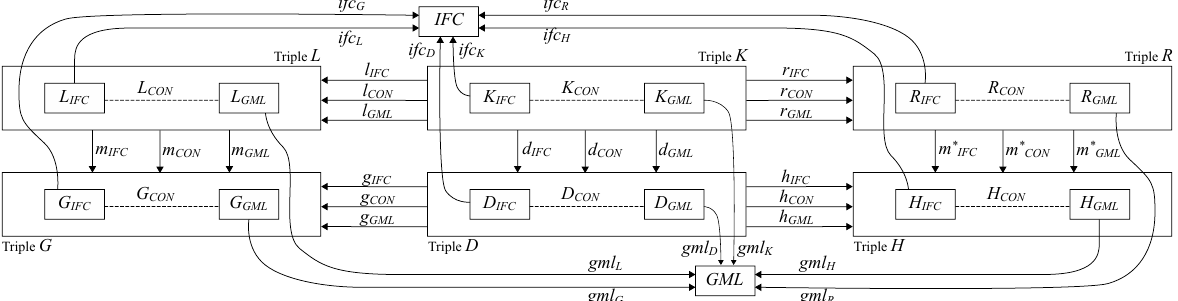
Figure 2. Double pushout for a triple graph rule with all participating graphs and